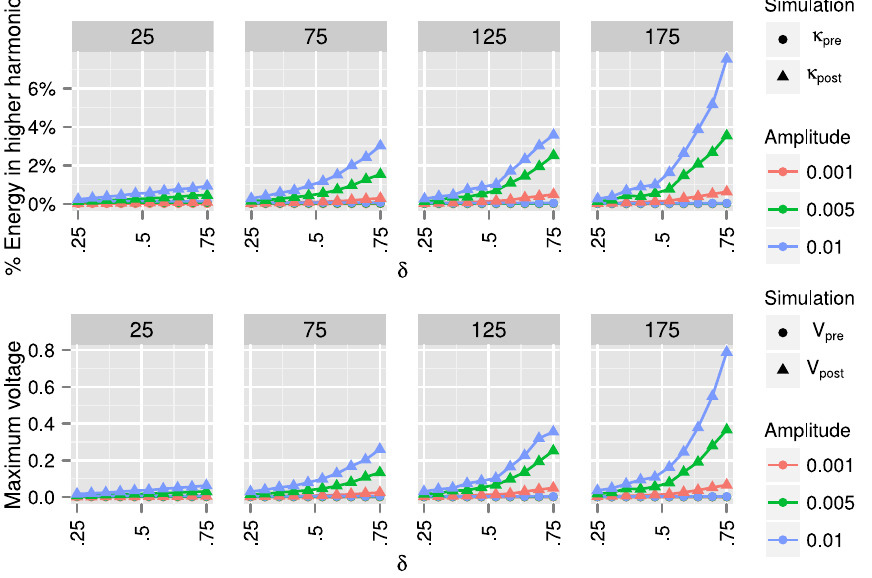
Figure 10. Erdo¨s-Re´nyi random graph results. From left to right, we present results for Erdo¨s-Re´nyi random graphs with N ~ 25 , 75 , 125 , and 175 nodes. For each graph, we use algorithm (36) to modify the inductances L such that the ratio of the smallest to the second smallest eigenvalue is d . We use pre and post to denote, respectively, the graphs before and after algorithm (36) is applied. By shrinking the gap between the first two eigenvalues, the energy transferred to higher harmonics (37) can be increased to k post [ ½ 1,8 (cid:2) % (depending on the graph size), and the maximum voltage (38) can be increased to V post [ ½ 0 : 1,0 : 8 (cid:2) (depending on the graph size). The results for Erdo¨s-Re´nyi graphs are much more strongly dependent on the number of nodes N than the results shown in Figures 8 or 9. Note that the peak voltages for the N ~ 175 graphs with forcing amplitude 0 : 01 are the largest voltages for any graphs considered in this paper. We can increase the peak voltages for smaller graphs by choosing a smaller value of the conductance than G i ~ 0 : 5 (for all nodes i ), the value used to compute the results in this figure.